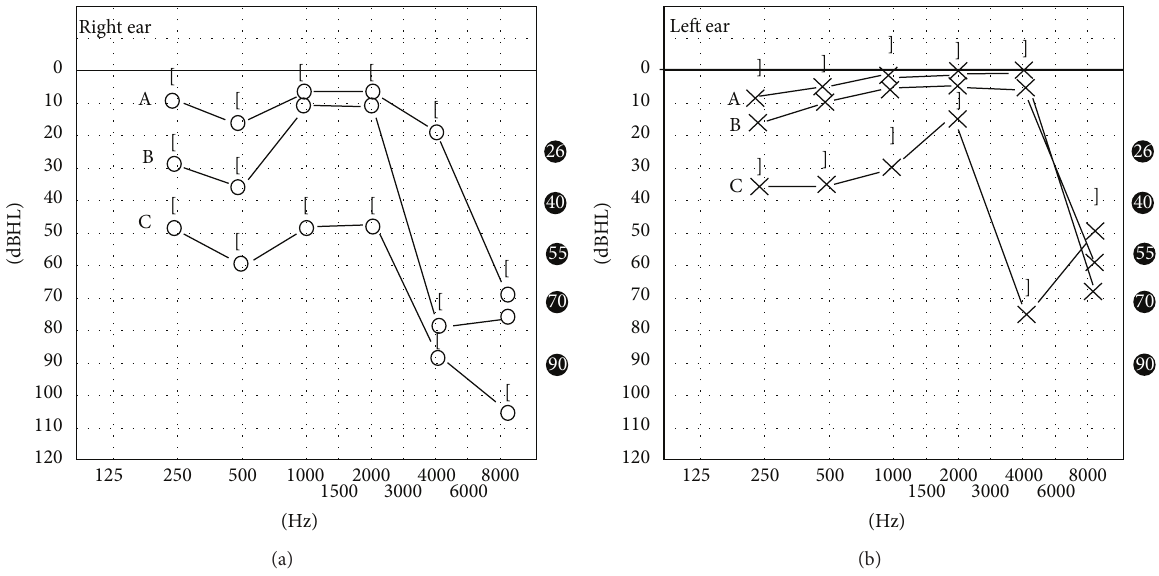
Figure 1: The patient’s pure tone audiograms (A) on admission, (B) one month, and (C) one year after the initiation of treatment.